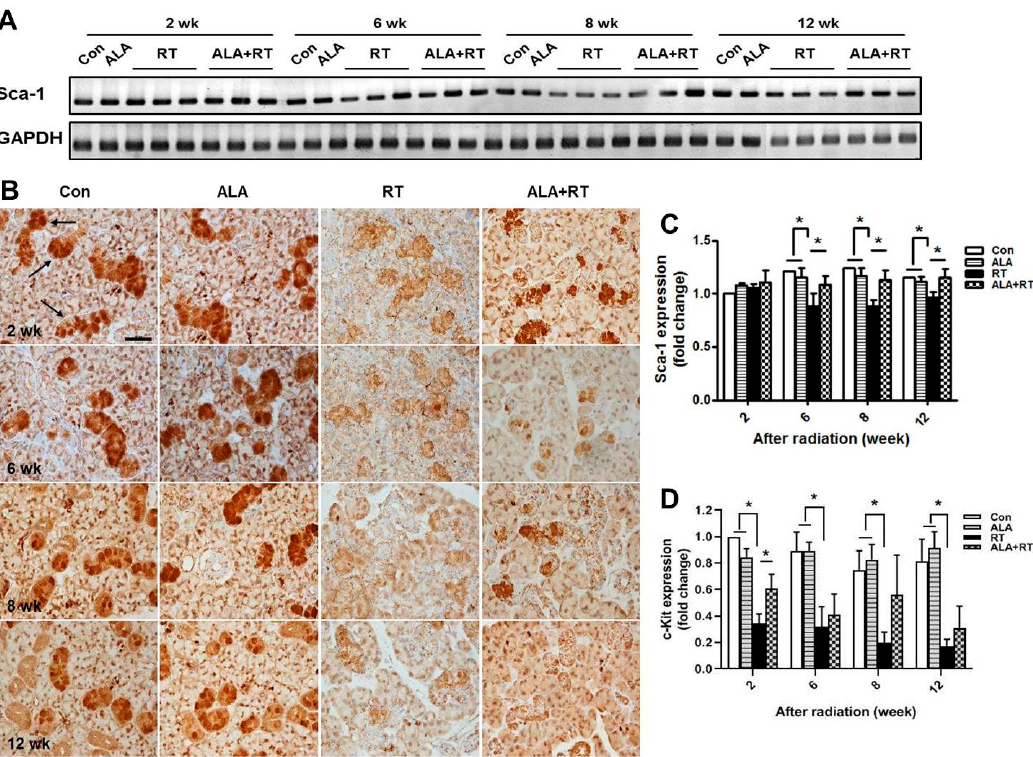
Figure 6. ALA ameliorates radiation-induced impairment of stem cells. Sprague–Dawley rats were subjected to 18 Gy radiation in the head and neck region. ( A and C ) SGs were collected at each time points, and RNA was extracted and subjected to reverse-transcription PCR analysis of Sca-1. GAPDH was used as the loading control. The expression level of Sca-1 is normalized to GAPDH. The expression in each group was represented as fold change. Con; control ( n = 3). ALA; ALA only treated group ( n = 3). RT; irradiation only group ( n = 3). ALA+RT; ALA plus irradiation groups ( n = 3). ( B and D ) The sections were immunostained with anti-c-Kit. Figures are representative images from each group. c-Kit positive signals on SG sections (B) and the quantification of staining intensity ( D ). Scale bar, 50 μ m. N = 3–4 SGs/group. The fold change is calculated as the ratio of the final value in each group to the value in control group at 2 weeks (set as “1”). Values are represented as the mean ± SEM. * p < 0.05.